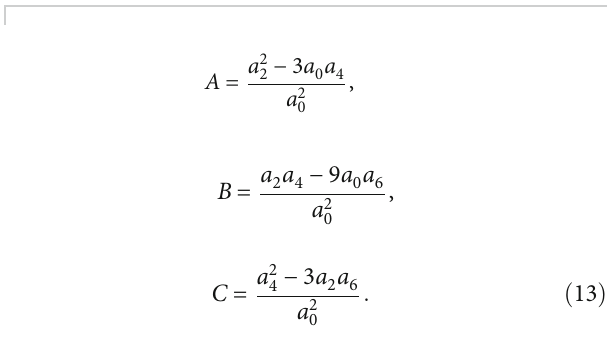
(cid:1) (cid:3)(cid:11) (cid:12) ffiffiffiffiffi p ξ a 2